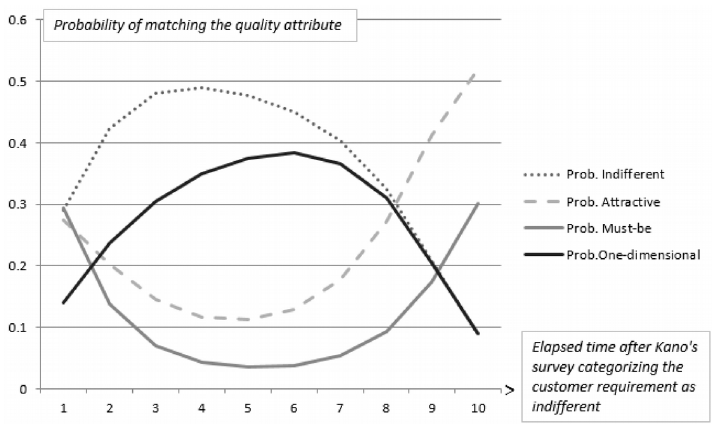
Figure 8. Expected trajectories of customer requirements designated as